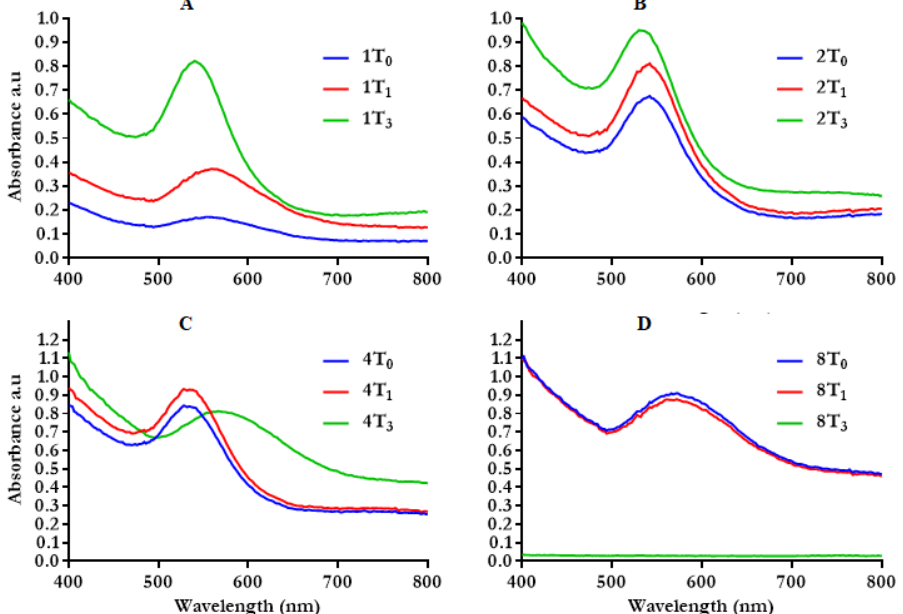
Figure 2. Effect of reaction time on the synthesis of HB-AuNPs at 70 °C using 1 mg/mL ( A ), 2 mg/mL ( B ), 4 mg/mL ( C ), and 8 mg/mL ( D ) of HBE. The numbers (1, 2, 4, and 8) represent the concentration of HBE in mg/mL; T 0 – T 2 represent the reaction time from 0 – 2